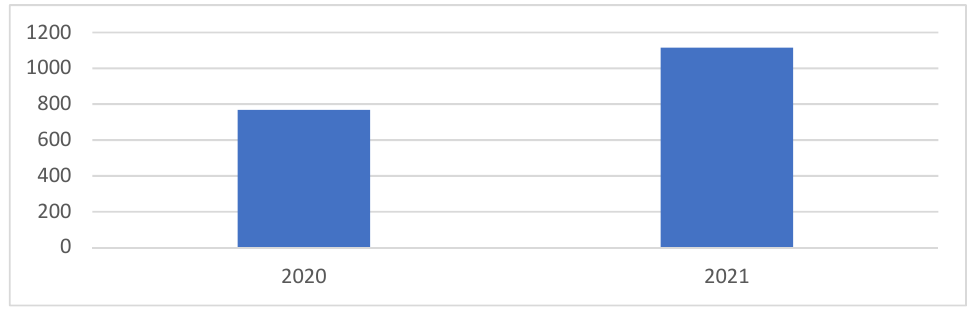
Figure 1. Prevalence of newly diagnosed patients with DM during the COVID-19 pandemic ( p -value = 0.0001).